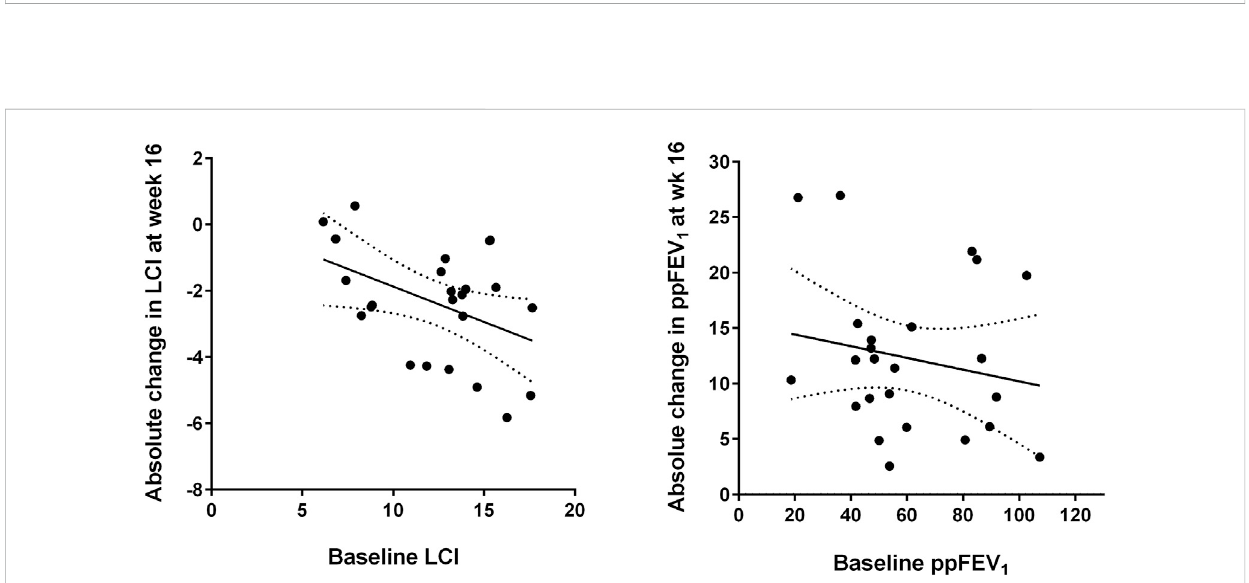
FIGURE 2 Absolute changes in lung clearance index (LCI, left) and per cent predicted forced expiratory volume in one second (ppFEV ₁ , right)after 16 weeks of elexacaftor/tezacaftor/ivacaftor (ELX/TEZ/IVA) treatment compared to the respective baseline values. The best- fi t linear regression lines and their 95% con fi dence bands are displayed (see text for correlation coef fi